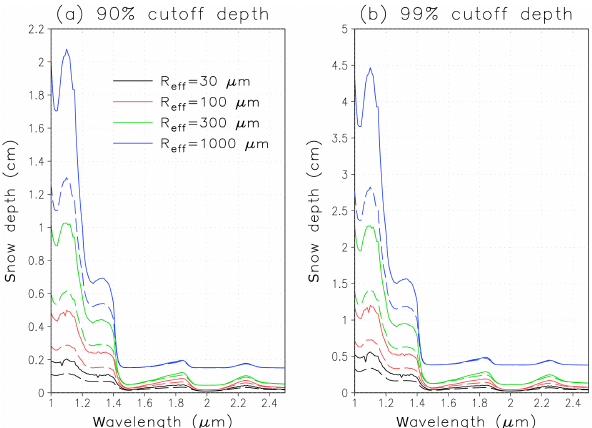
Figure 8. Spectral 90% (a) and 99% (b) cutoff depth of the semi- infinite albedo in the SWIR region for diffuse incident radiation. Snow density is 400kgm − 3 . The cases of effective particle radius of 0.03, 0.1, 0.3, and 1mm (black, red, green, and blue lines, respec- tively) are illustrated for the assumption of spherical shapes (contin- uous lines) and droxtal shapes (dashed lines), for a mono-disperse size